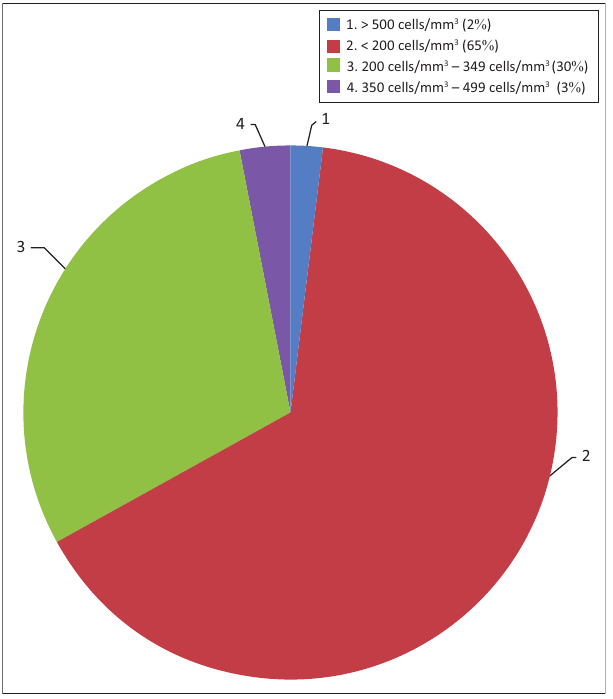
FIGURE 2: CD4 count of patients at initiation of combination antiretroviral therapy. ( n =